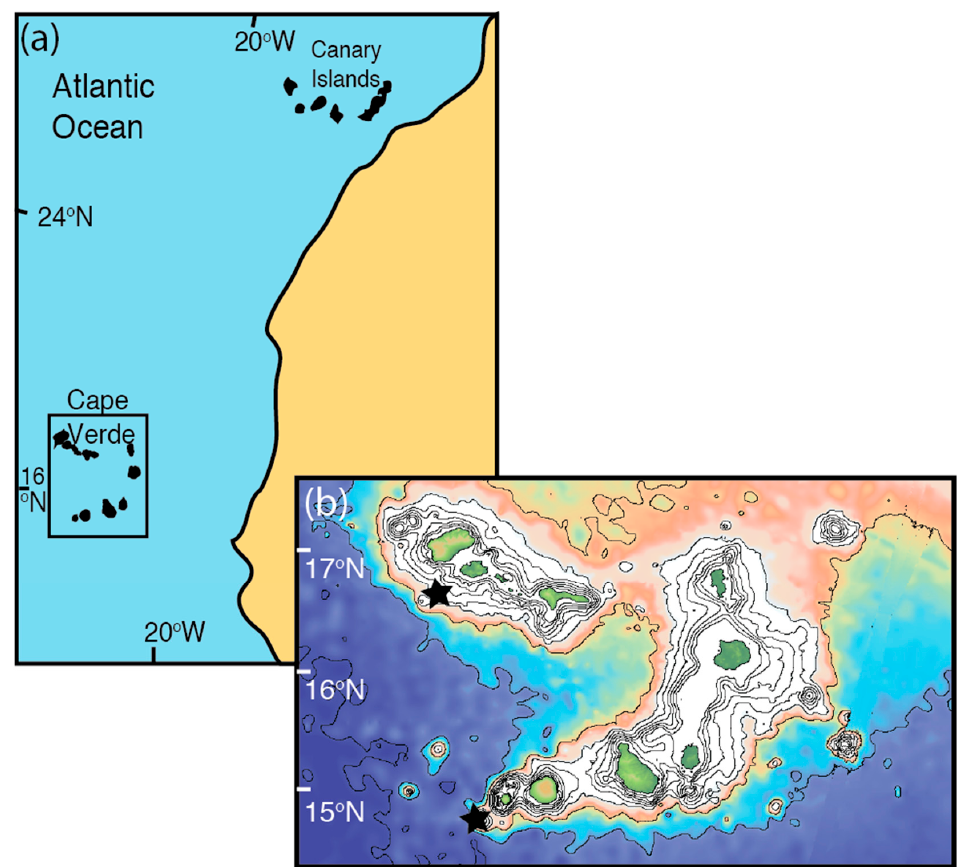
Figure 1. ( a ) Location map of the Cape Verde archipelago, ( b ) shows the Cape Verde islands and bathymetry including certain seamounts (credit due to [16]). The oceanic plateau was extensively sampled by ROV dives and dredging during the Meteor M80/3 expedition to Cape Verde in January 2010. The stars mark the locations of xenolith bearing samples featured in this study. The southwestern star depicts the Cadamosto Seamount located at the southwest of the southern chain of volcanic islands. The other star marks the Charles Darwin Volcanic Field, which lies southwest of the northern volcanic island chain, on the lower submarine flank of Santo Antão.